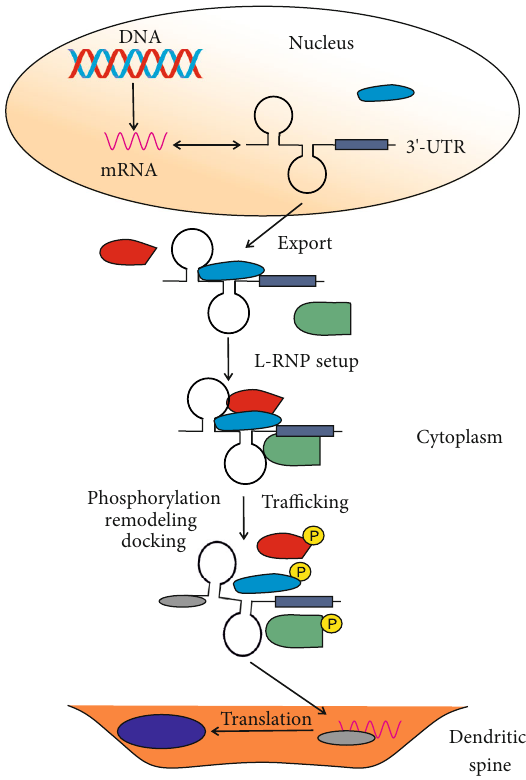
Figure 2: mRNA-protein and protein-protein interactions in localized mRNA expression in neurons. An mRNA resulting from the transcription of a gene in DNA is represented by its 3 ′ -UTR (untranslated region) containing a segment of the speci fi c sequence ( fi lled box) and a higher order structure, represented by two stem loops. These elements handle localized mRNA expression and are recognized and bound by speci fi c proteins (represented by a light- blue object) and exported into the cytoplasm. Then, other RNA- binding proteins, represented by red and green objects, bind to the mRNA 3 ′ -UTR to form a localizing ribonucleoprotein (L-RNP), which is assisted by other proteins (not presented here) and supports the tra ffi cking of mRNA to speci fi c locations in the dendritic spine where it is translated. Before that, mRNA can be remodeled (symbolized by changes in its secondary con fi guration and protein (grey oval) binding), docked in the dendrite spine, preceded by phosphorylation (the P letter in a yellow circle) and disassociation of the L-RNP proteins, and translated to produce the Arc protein (dark blue